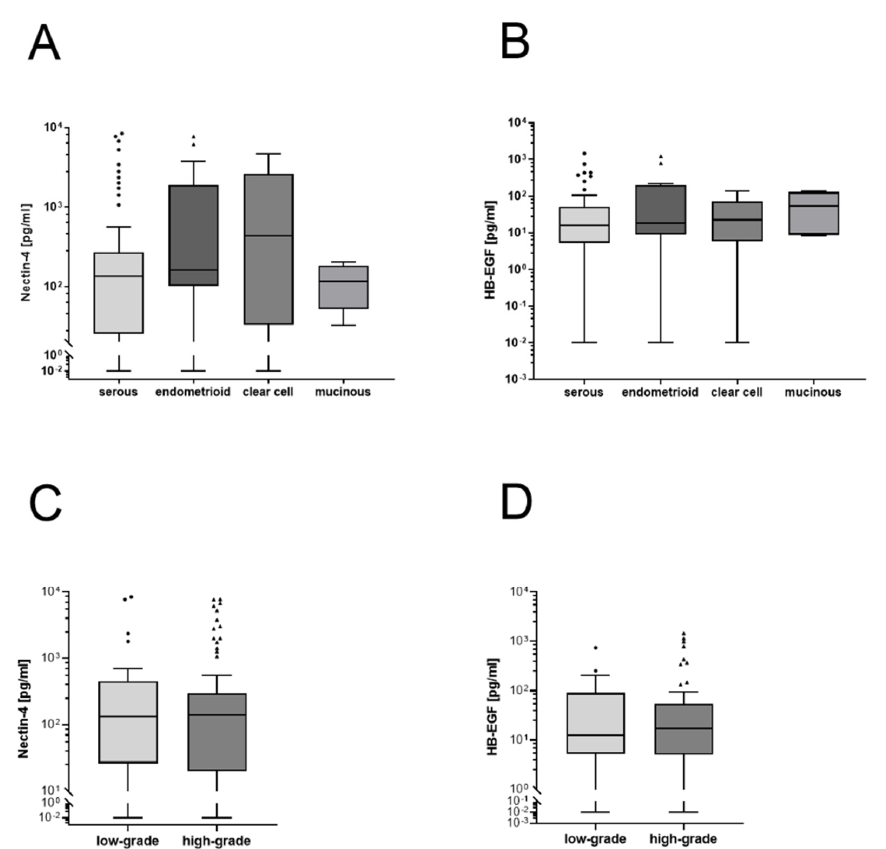
Figure 3. Boxplots of Nectin-4 and HB-EGF levels in serum according to histological subtypes and grading. ( A ): No significant difference between endometrioid, serous, clear cell and mucinous subtypes regarding the Nectin-4 levels, Kruskal–Wallis test ( p = 0.127). ( B ): No significant differences in HB-EGF levels between histological subtypes, Kruskal–Wallis test ( p = 0.73). ( C ): No evidence of differences in Nectin-4 level with grading, Mann–Whitney test ( p = 0.77). ( D ): No evidence